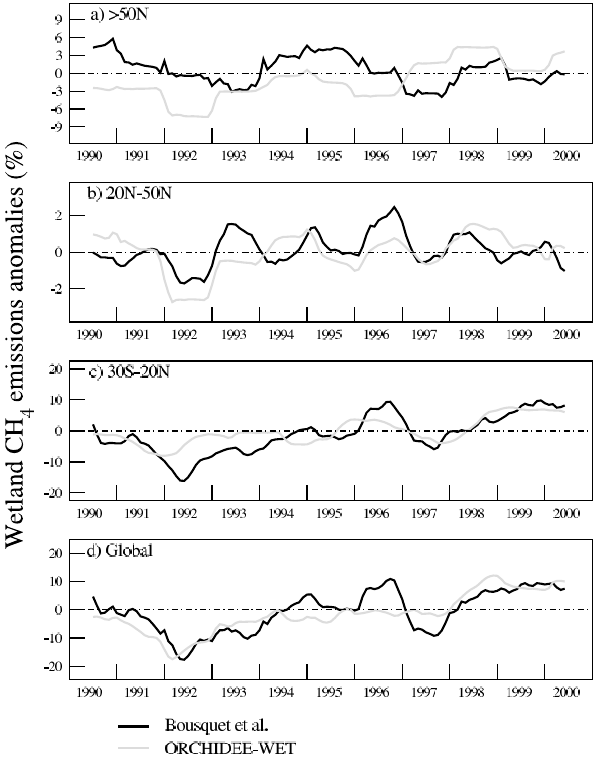
Fig. 2. Year-to-year variability of simulated CH 4 wetlands emis- sions (grey curve) and comparison with a top-down approach (Bousquet et al., 2006) (black curve) over 1990–2002 period. The anomalies obtained by 12 months-shift mean are divided by the global annual average of each estimation (Bousquet et al., 2006 or